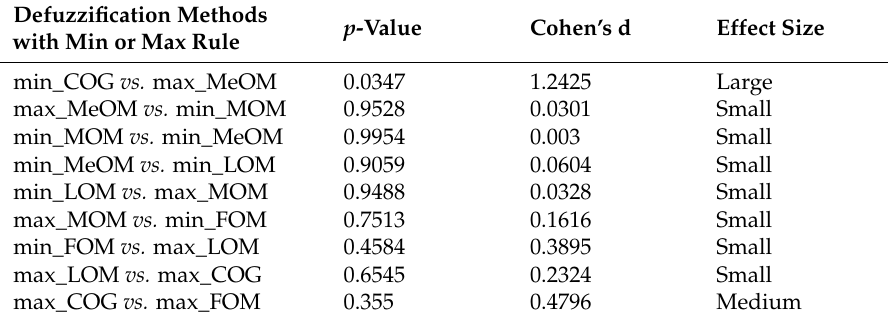
Table 5. Cohen’s d and effect size calculated between each fuzzy method sequentially according to the correlation value